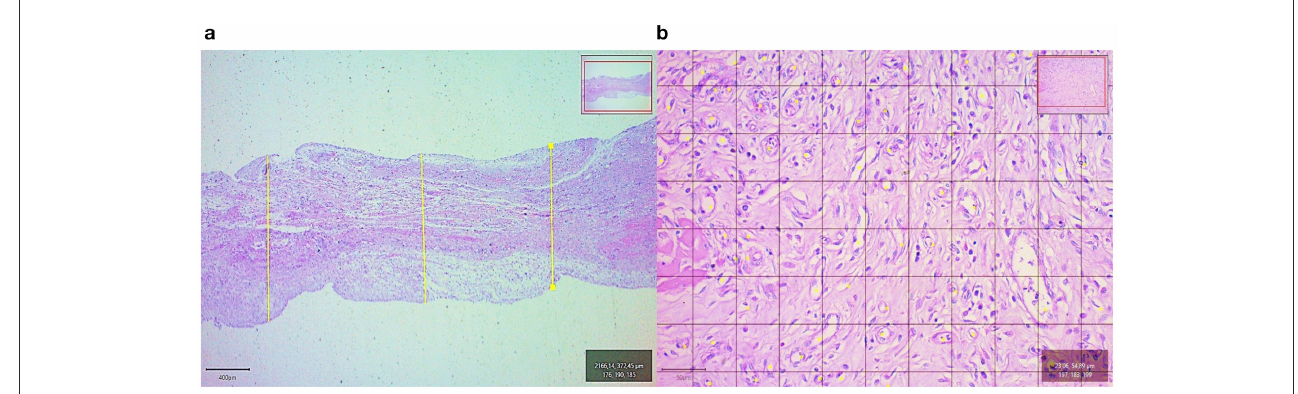
FIGURE1 (a) Thickness measurement of the induced membrane at three different sites (yellow lines) (HE, 2.5x) and (b) blood vessel counting (yellow dots) (HE, 20x) in a chicken from Group 1 (bone cement) on day 21 after surgery, using the QuPath-0.3.2